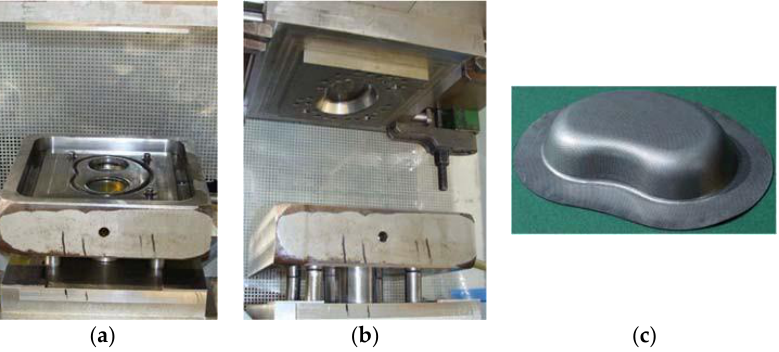
Figure 2. ( a , b ) Tool for passive hydroforming; ( c ) test components applied with tool (material: DX54D steel, wall thickness 0.6 mm), according to [7]. Table 2. Expected cycle times for active and passive hydroforming of bipolar plates for production from coil.